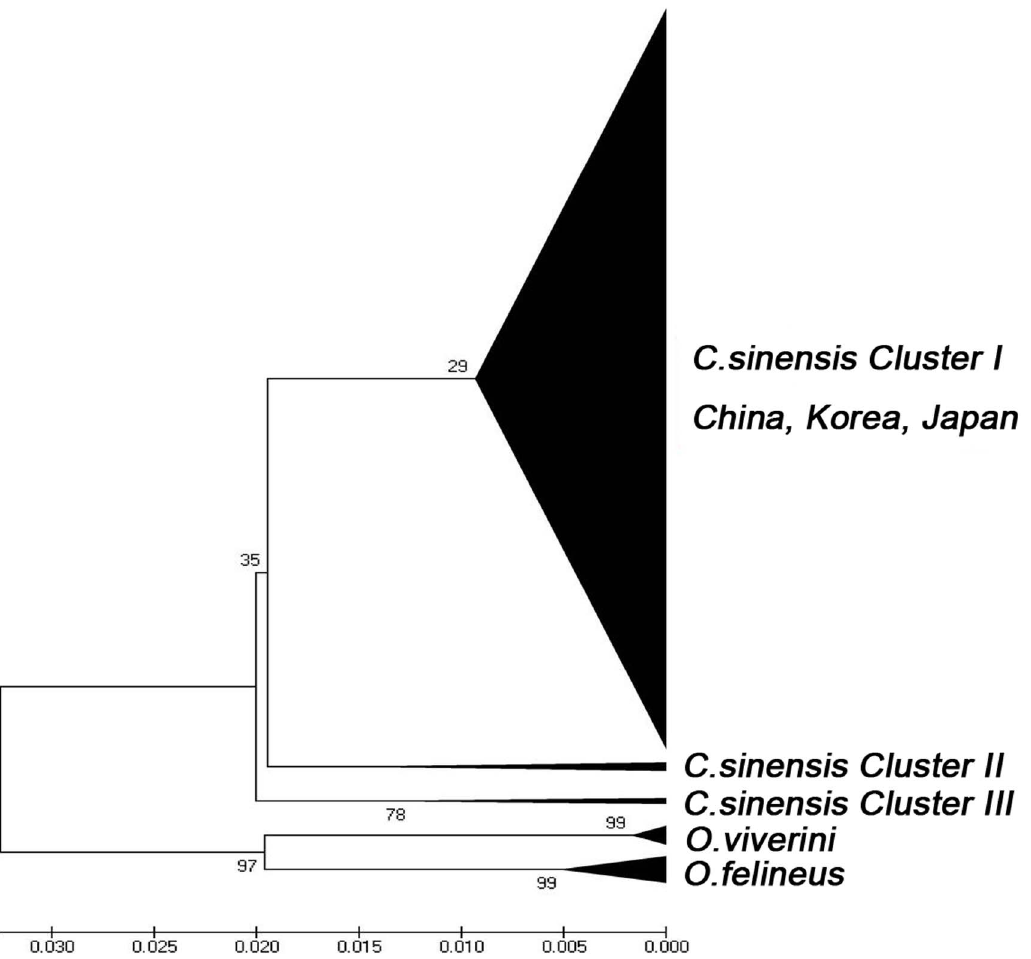
Figure 3. Phylogram constructed from UPGMA analysis of p-distances based on concatenated sequences of the ITS1 locus using global penal isolates (n=288, C.sinensis : 271, O.viverrini : 7, O.felineus : 10). The fixed cluster I (red) is composed of 234 isolates from 17 provinces in China and 14 isolates from Korea and Japan. Cluster II (light blue) is composed of 16 isolates from Henan, Shannxi, Zhejiang, Guangxi, Anhui and Hubei province. Cluster III (light red) is composed of 6 isolates from Henan province and an ancient corpse from Hubei province in 176 BC. Seventeen O. viverrini (purple) and O. felineus (green) were used as outgroups. The percentage replicates are 1000 replications. The evolutionary distances were computed using the Maximum Composite Likelihood method.